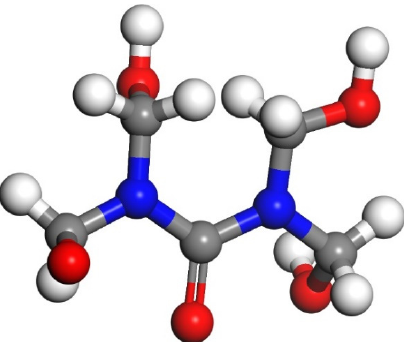
Figure 1. The monomer structure model of urea–formaldehyde (UF) resin (Color legend: hydrogen H (white); oxygen O (red); nitrogen N (blue) carbon C (grey)). Materials 2020 , 13 , x FOR PEER REVIEW